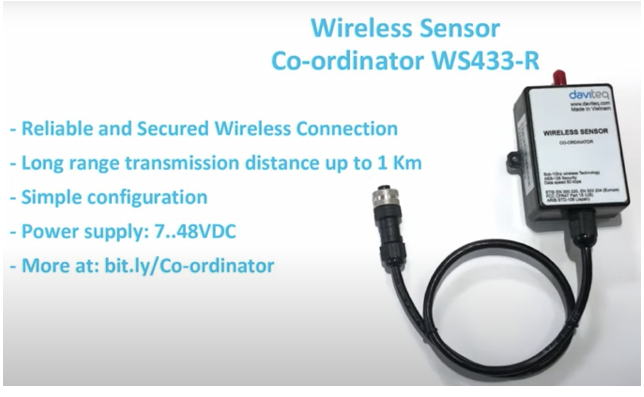
Figure 3. Wireless sensor co-ordinator [7].